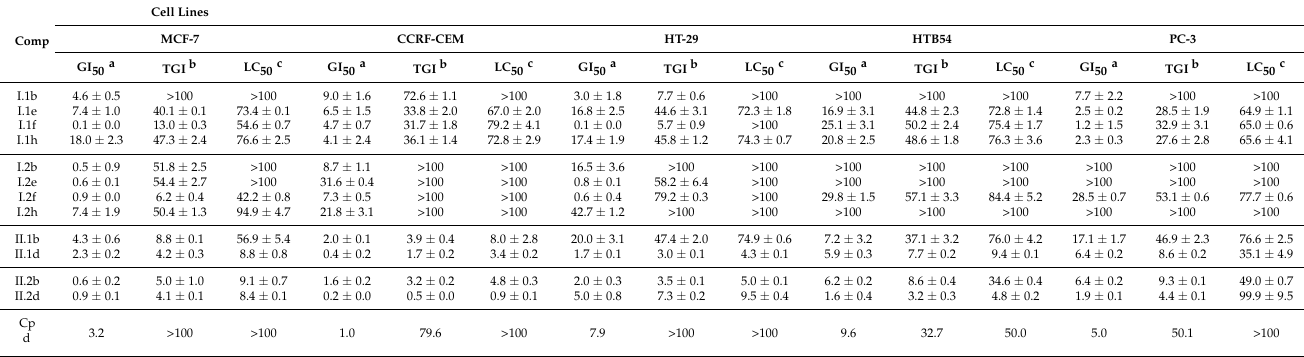
Table 1. Average ± SEM values for GI 50 , TGI and LC 50 parameters in MCF-7, CCRF-CEM, HT-29, HTB54 and PC-3 cell lines.